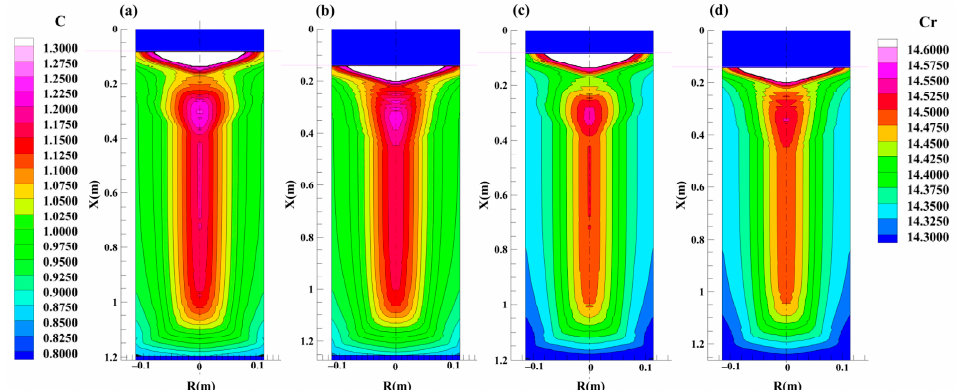
Figure 22. Distribution of C and Cr concentration with varying slag thickness: ( a ) C concentration,